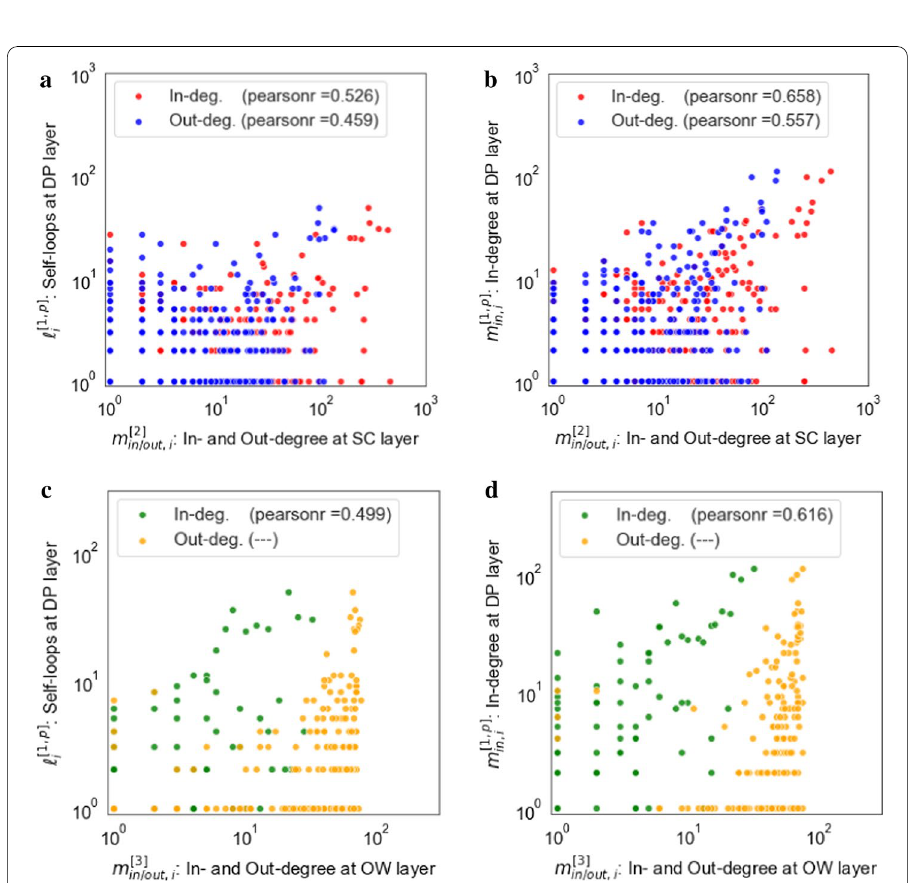
Fig. 5 Interlayer degree correlations. The Upper (lower) two figures illustrate the relations between the number of drug pipelines and the number of supplier–customer (ownership) links. The left (right) vertical axis corresponds to the number of self-loops (in-degree) at the drug pipeline layer’s launched state. Since the upper limits at approximately 100 for the out-degree in the ownership layer because of the data collection threshold, we do not compute the Pearson correlation coefficients of